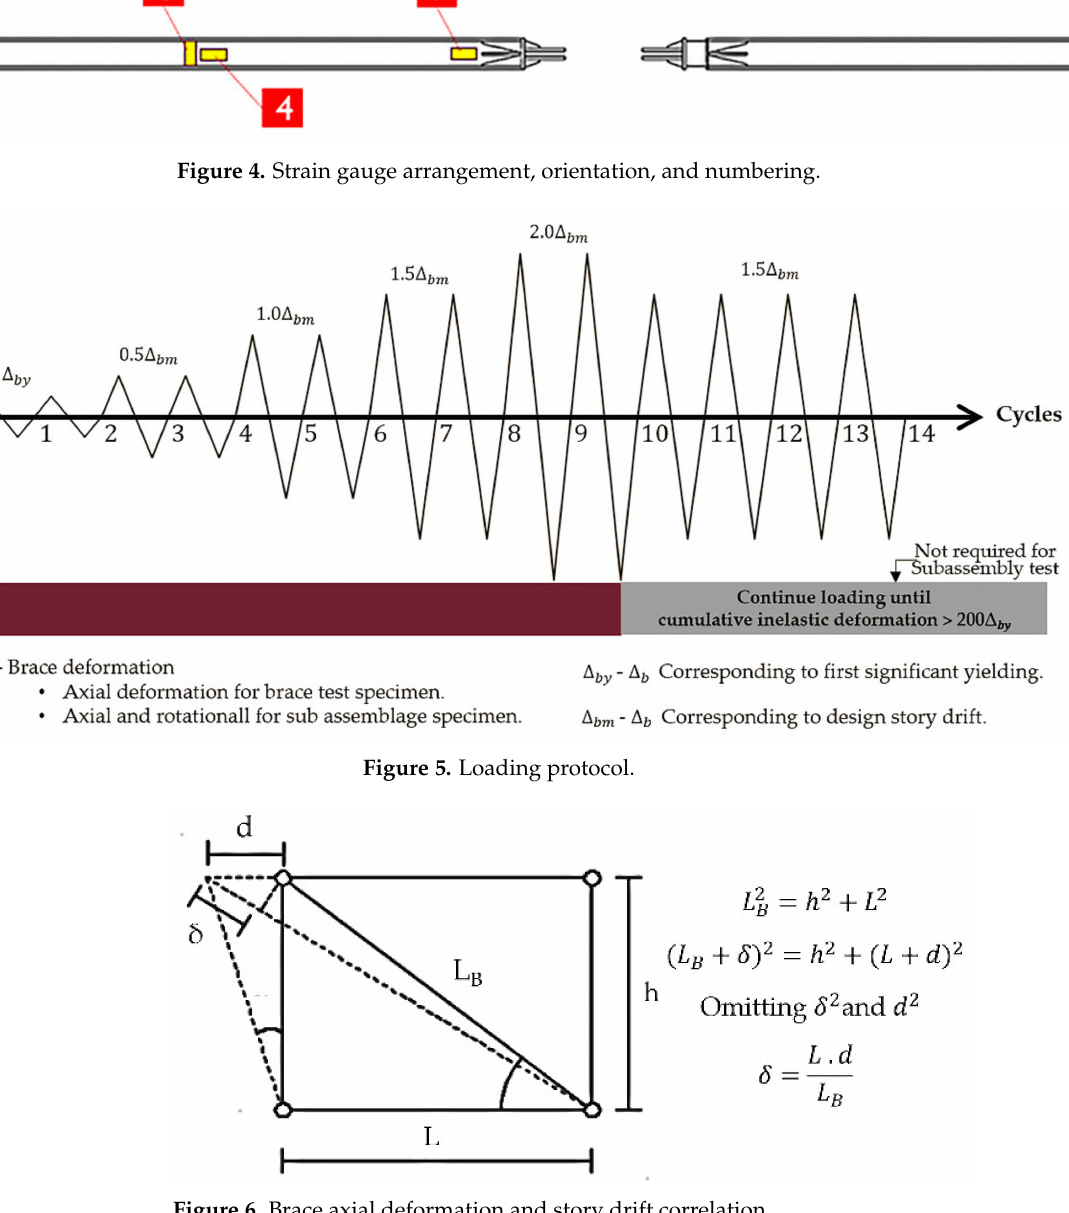
Figure 6. Brace axial deformation and story drift